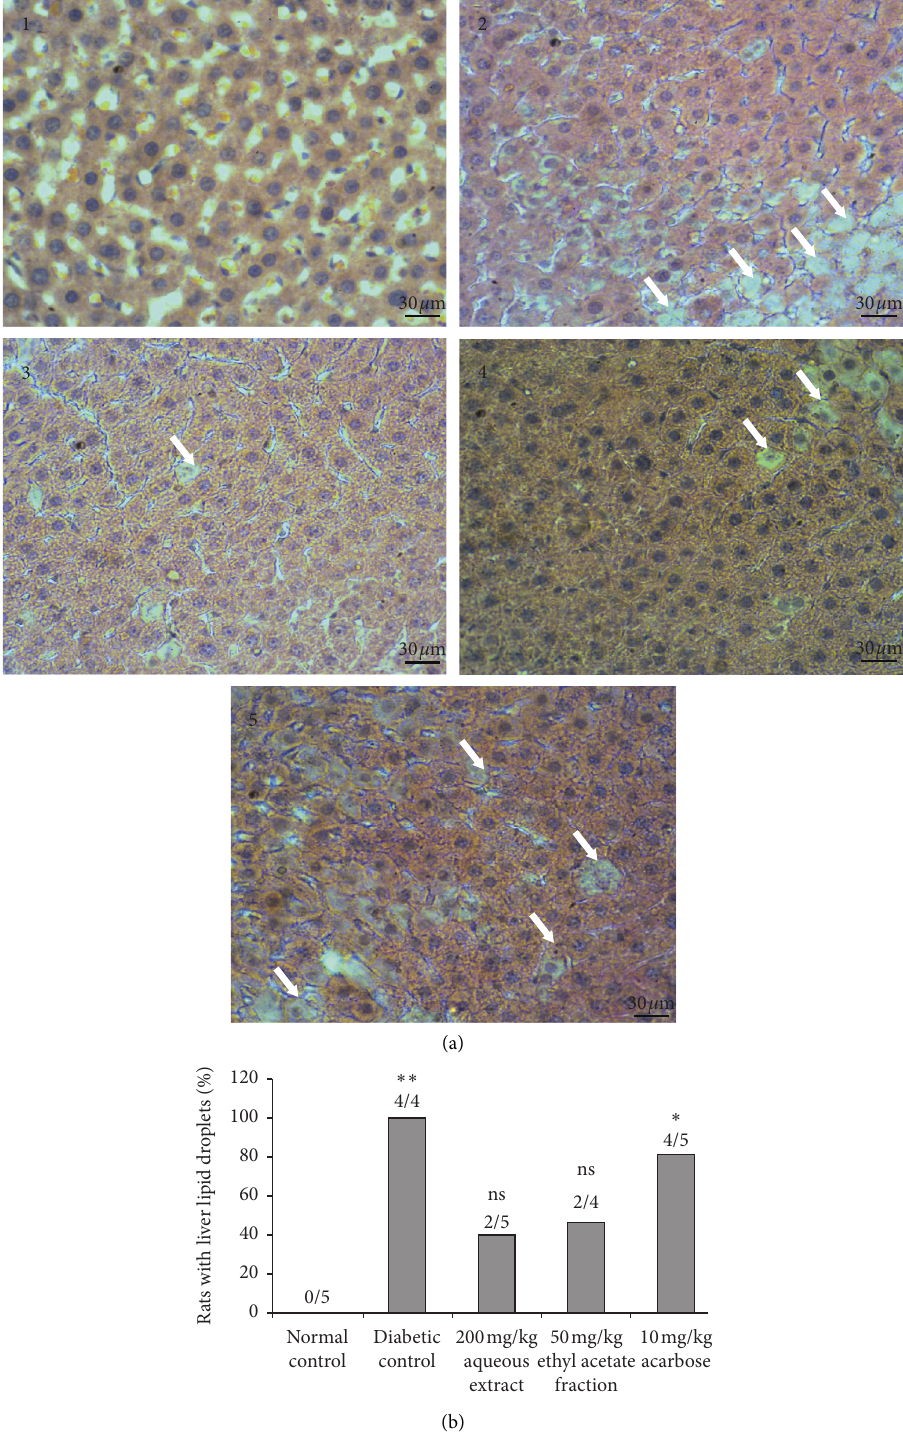
Figure 5: Effect of 200mg/kg AqTh, 50 mg/kg EaTh, and 10mg/kg acarbose treatment on the liver of STZ-induced diabetic rats after 4-week treatment. (a) Histological appearance of liver tissue in normal (1), diabetic (2), AqTh-treated (3), EaTh-treated (4), and acarbose-treated rats (5). (b) Percentage of rats with liver lipid droplets. Sections were stained in hematoxylin and eosin and observed in light microscope (original magnification × 400). White arrow: lipid droplets. Each value represents the means ± SEM. n � 4–6. x/x: number of rats with lipid droplets in the group. ∗ p < 0 . 05 and ∗∗ p < 0 . 01 compared to normal rats. ns p > 0 . 05 compared to normal rats. All statistical tests were used with one-tail p